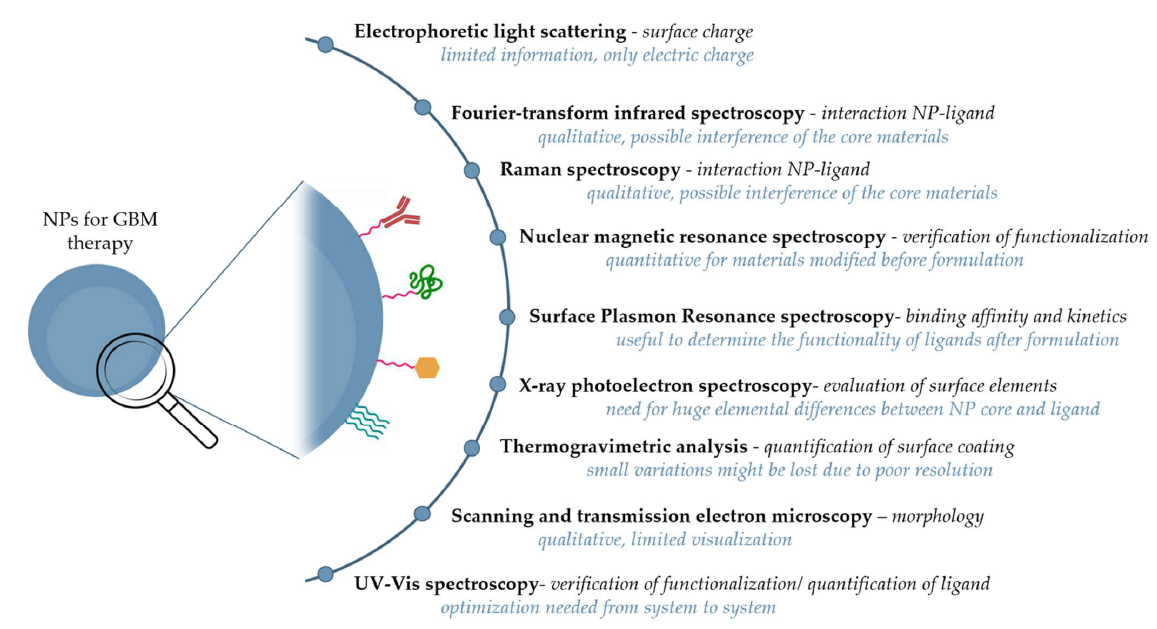
Figure 2. Techniques used for surface characterization of NPs for GBM therapy. Abbreviations: GBM—glioblastoma multiforme; NPs—nanoparticles; UV-Vis—ultraviolet-visible.